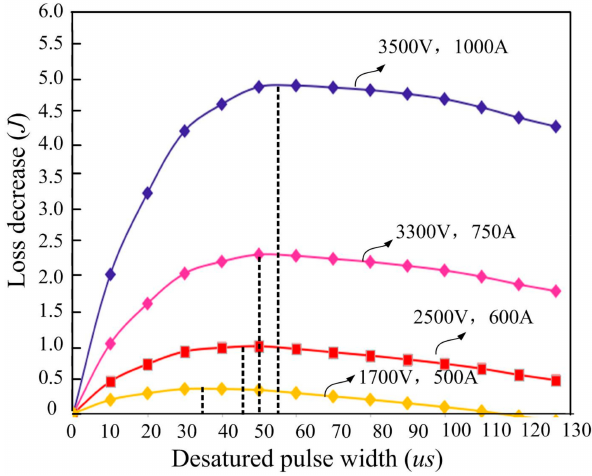
Figure 9. Diagram of the relation between optimal loss and the desaturation pulse time at different